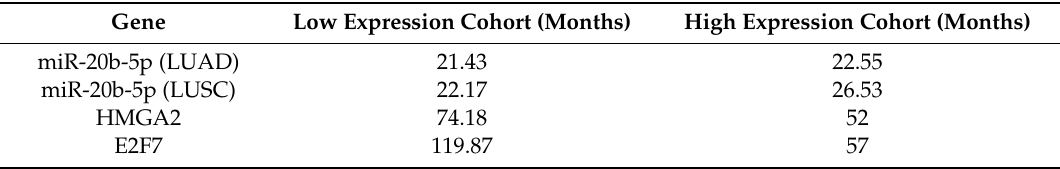
Table 3. Median survival time in di ff erent expression cohorts with respect to miRNA (miR-20b-5p) and TFs (HMGA2, E2F7).